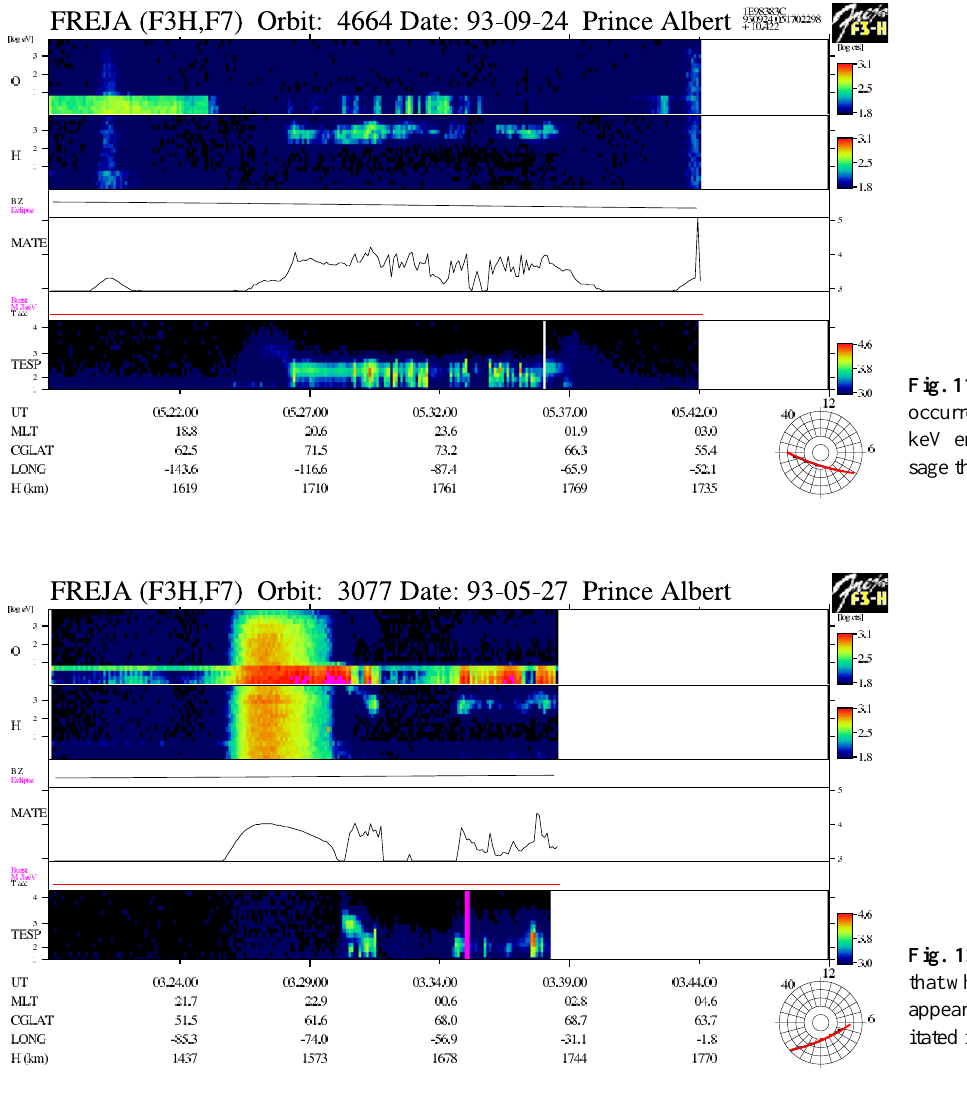
Fig. 12. A full-pass CSP illustrating that when the precipitated electrons dis- appear (03:31–03:34:30UT) the precip- itated ions also